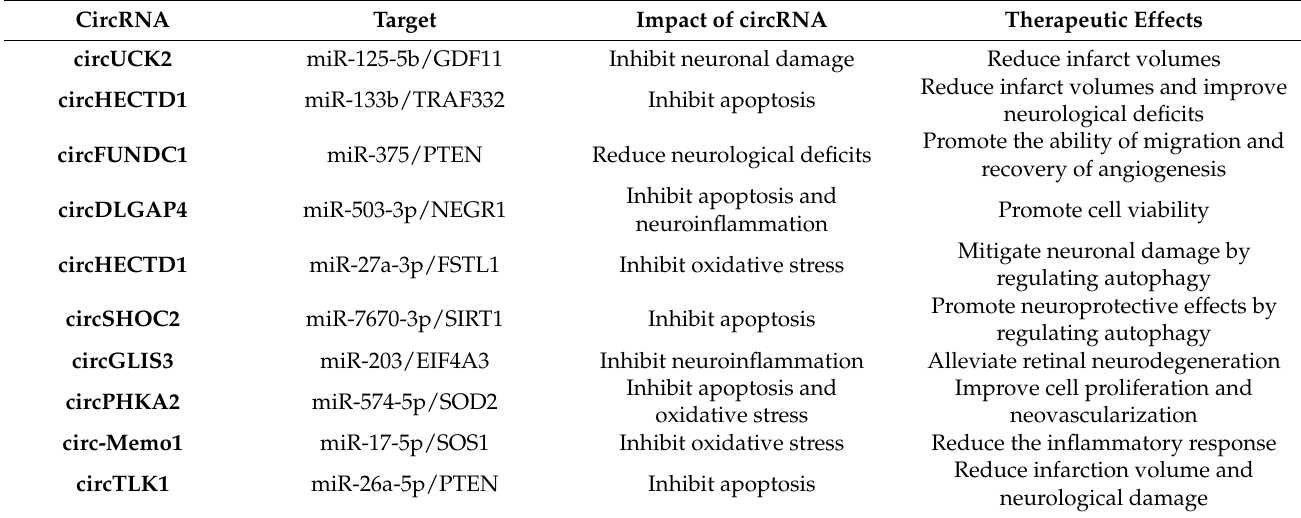
Table 2. Therapeutic effects of circRNA in ischemic